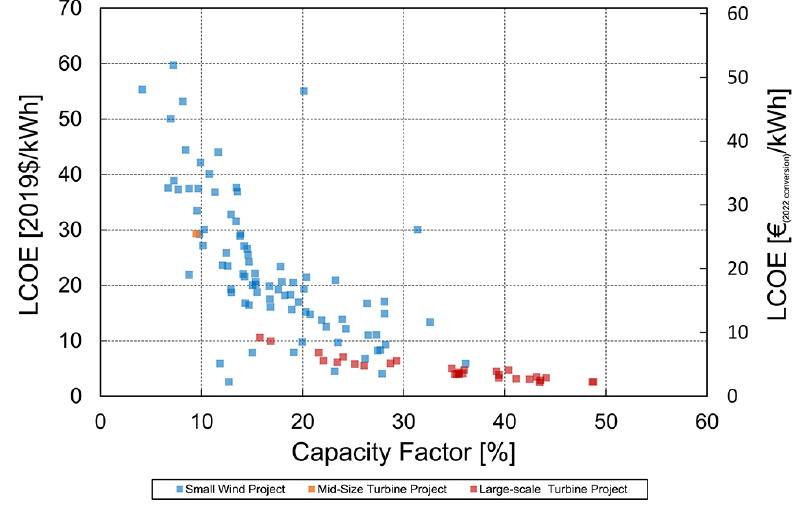
Figure 9. Relationship between LCOE and capacity factor for SWT projects. Data from Orrell et al.